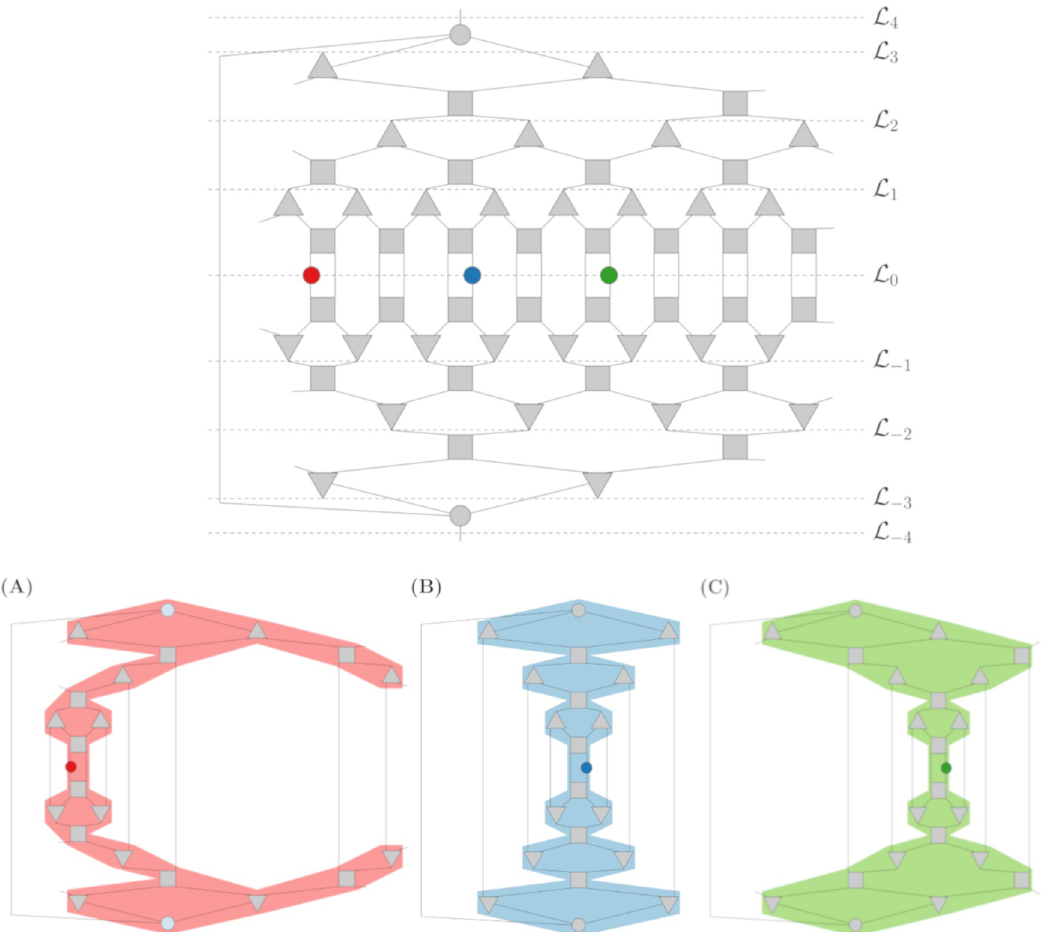
Fig 1. (Top) A 1D binary MERA with a 16-site lattice and 3 levels of coarsening; three operator placements are highlighted (red, blue, green). (Bottom) Causal cones and final tensor networks for each of the three highlighted operators. Note that the tensor networks for the left-most (red) and right-most (green) operators are isomorphic to one another, but structurally distinct from the middle (blue) operator’s